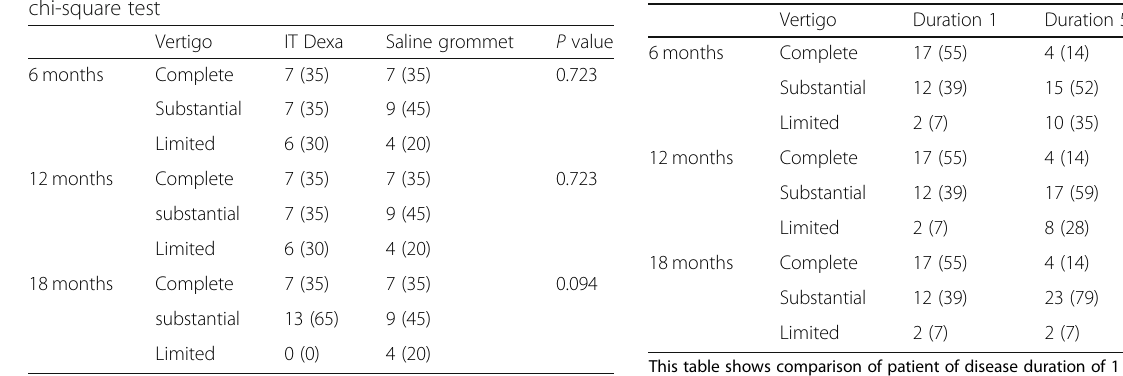
Table 9 Comparison of the 2 disease duration groups in the total sample regarding control of vertigo by chi-square